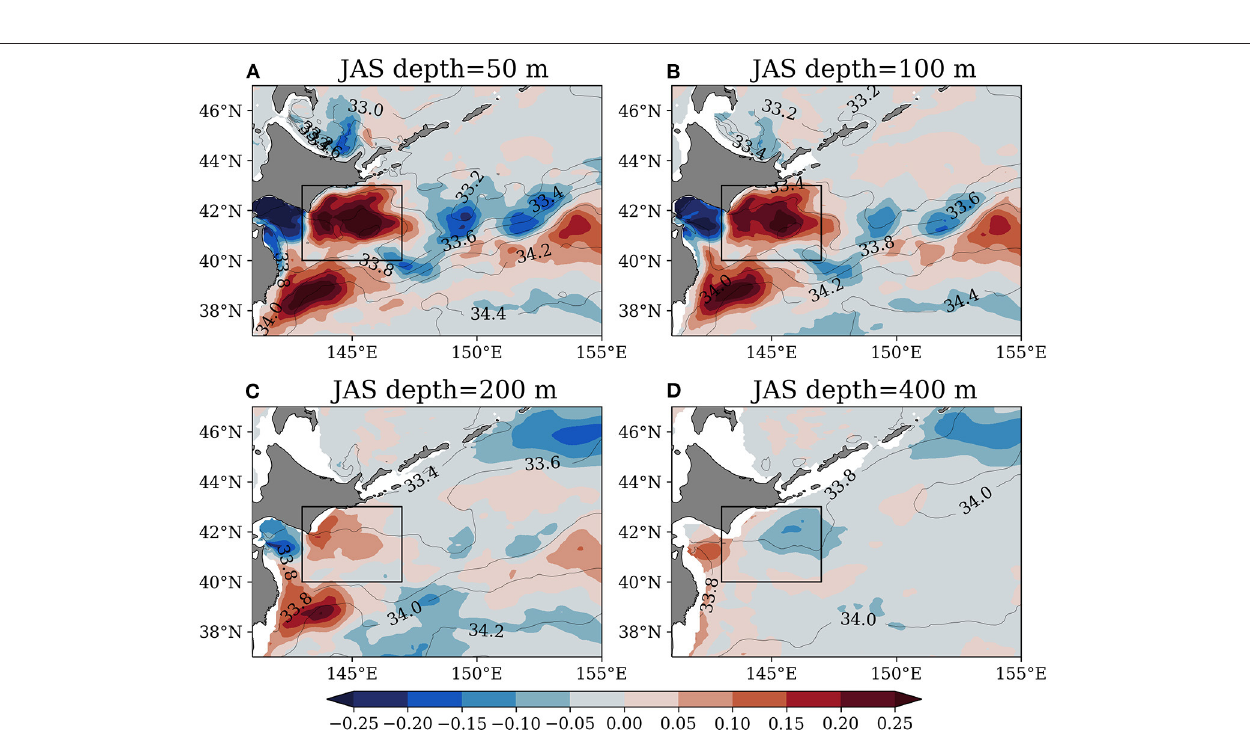
FIGURE 9 | Deviation of the 2010-2016 average salinity at each depth from the 1993-2009 average (color) and the 2010-2016 average salinity at each depth (contour) of the FRA-JCOPE2 reanalysis. (A) At 50m. (B) At 100m. (C) At 200m. (D) At 400m.